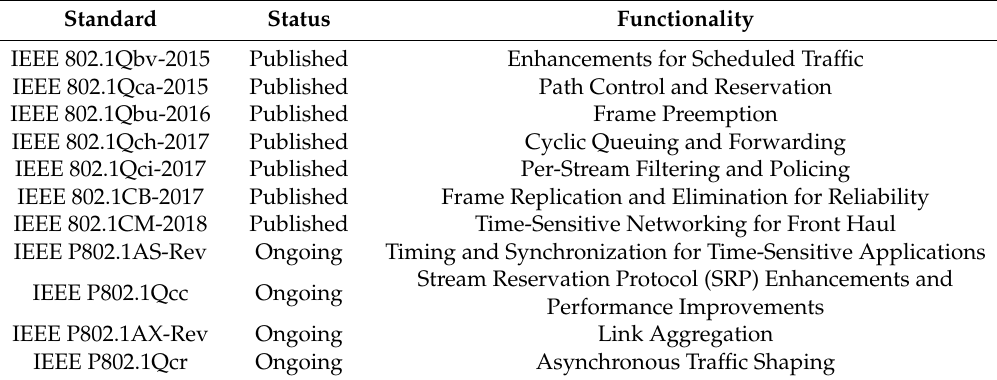
Table 1. Development status of time-sensitive network (TSN) standards.